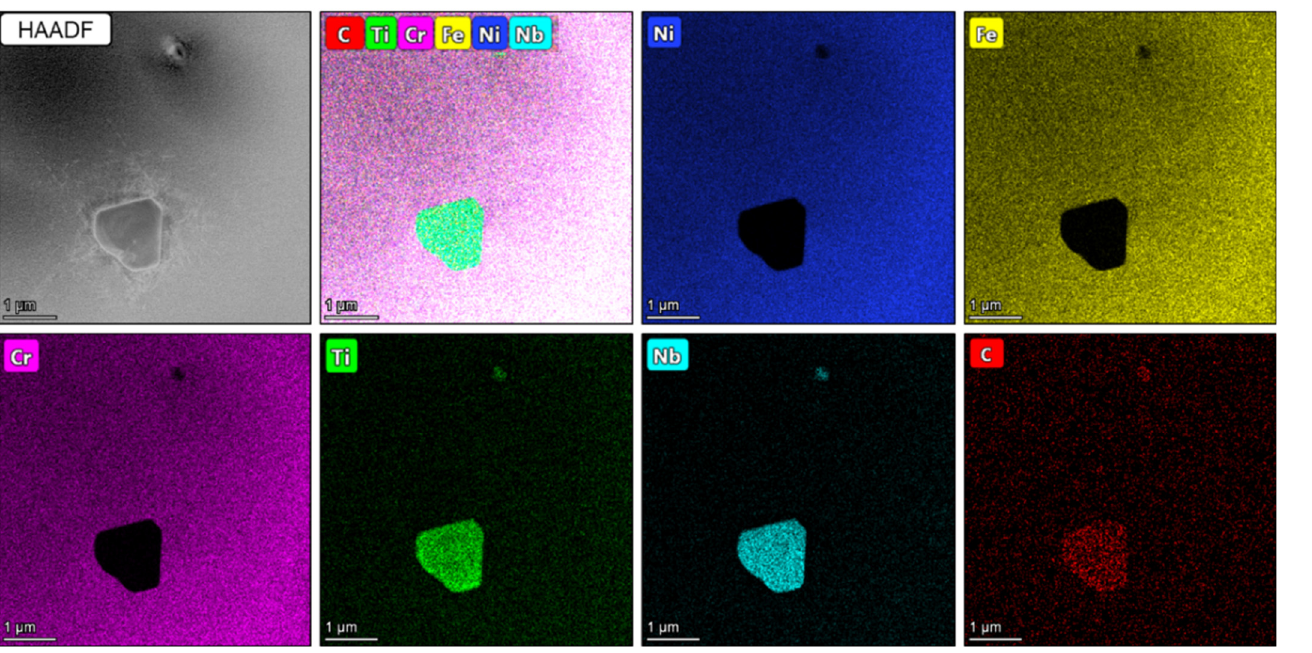
Figure 3. HAADF-STM image of the 945A Ni-based alloy and the related EDS mapping results, the first figure is the HAADF image, element distribution image and the independent element distribution images of Ni, Fe, Cr, Ti, Nb and C, respectively.